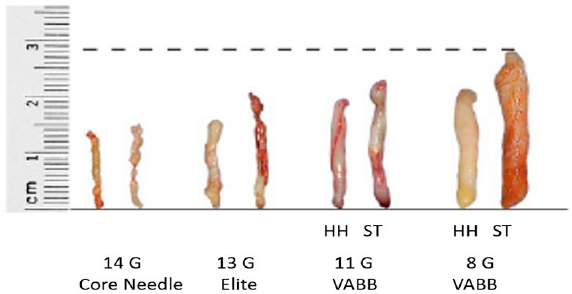
Figure 4. Reference scheme for average weight and size of whips in the main currently used ultrasound (HH) and stereotaxic (ST) bioptic techniques: the differences in volume and weight among the 14G CB (12 g), 13G VABB Elite (60 g) 11G VABB Mammotome ( ≃ 100 g) and 8G VABB Mammotome ( ≃ 300 g) samples are shown.